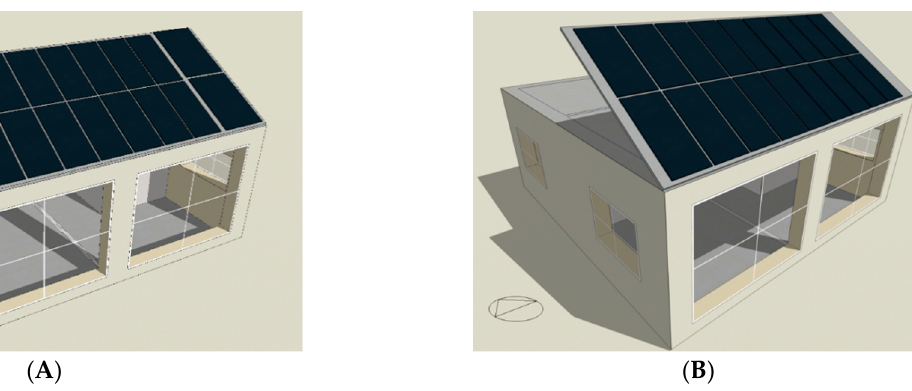
Figure 5. The arrangement of solar thermal collectors and photovoltaic panels: ( A ) the combination of both systems (16 PV panels and 2 STC collectors); ( B ) only the PV system (18 PV panels).